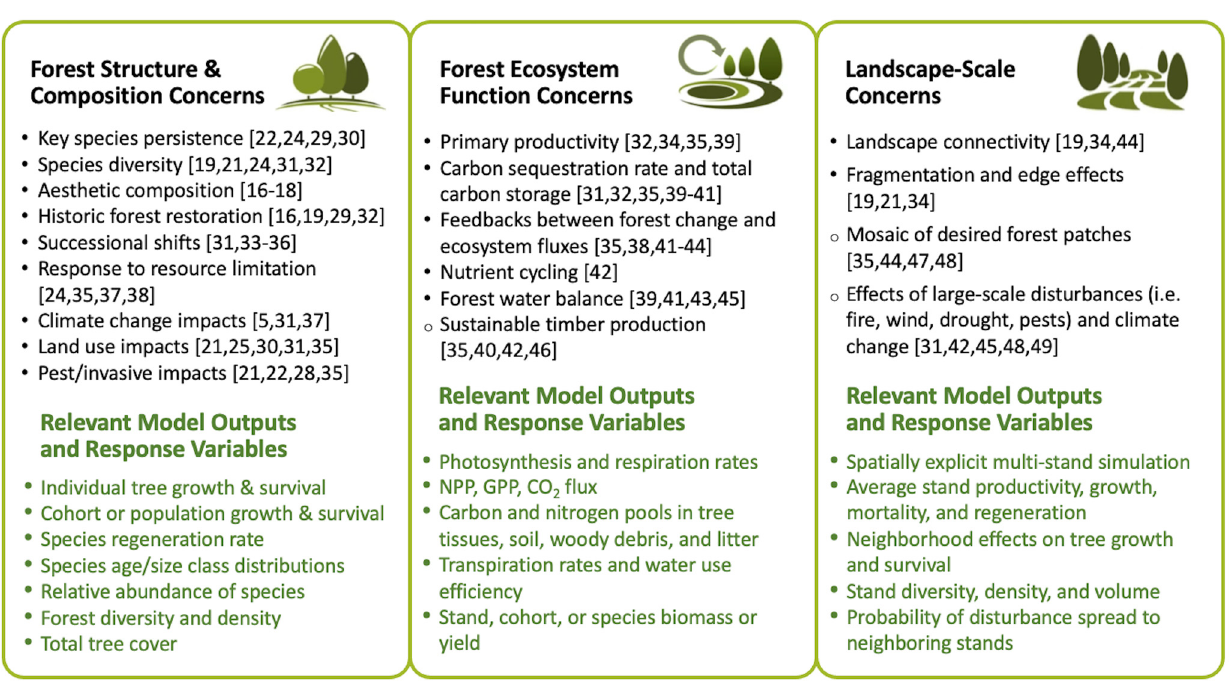
Figure 1. Small forest management concerns that can be informed by forest dynamics models, and the types of forest dynamics model outputs and response variables that can help address them. They are grouped in columns as issues related to forest structure and composition, ecosystem function, and landscape-scale patterns and processes. Management concerns with closed bullets may be relevant for many types of small forests, including urban forests, parks, isolated forest fragments, and small parcels within contiguous forested landscapes. Open bullets, which relate to timber production and larger forested matrices, are generally not relevant for urban forests. Superscripted citations provide examples from the literature [5,16–19,21,22,24,25,28–49].